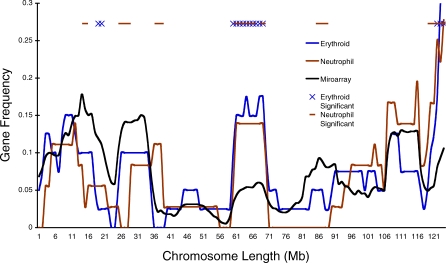
The Lineage-Specific Co-Regulated Genes Have Unique Chromosomal DistributionsThe erythroid, neutrophil, and microarray sliding-window gene distributions (Figure 1B) were plotted along all of the chromosomes (Figure S2). The sliding-window analysis is depicted along Chromosome 7, demonstrating the linear gene frequency of the microarray and co-regulated genes from the lineages (genes in the window are represented as a ratio of total genes of the microarray or lineage, respectively). An exact binomial test reveals regions of the chromosome that are either significantly enriched or depleted for lineage genes as compared to the microarray, X for erythroid and — for neutrophil. In total, there are 31 erythroid and 37 neutrophil domains across the genome (with at least one domain on most chromosomes) that are enriched for lineage-specific genes (Figure S2).